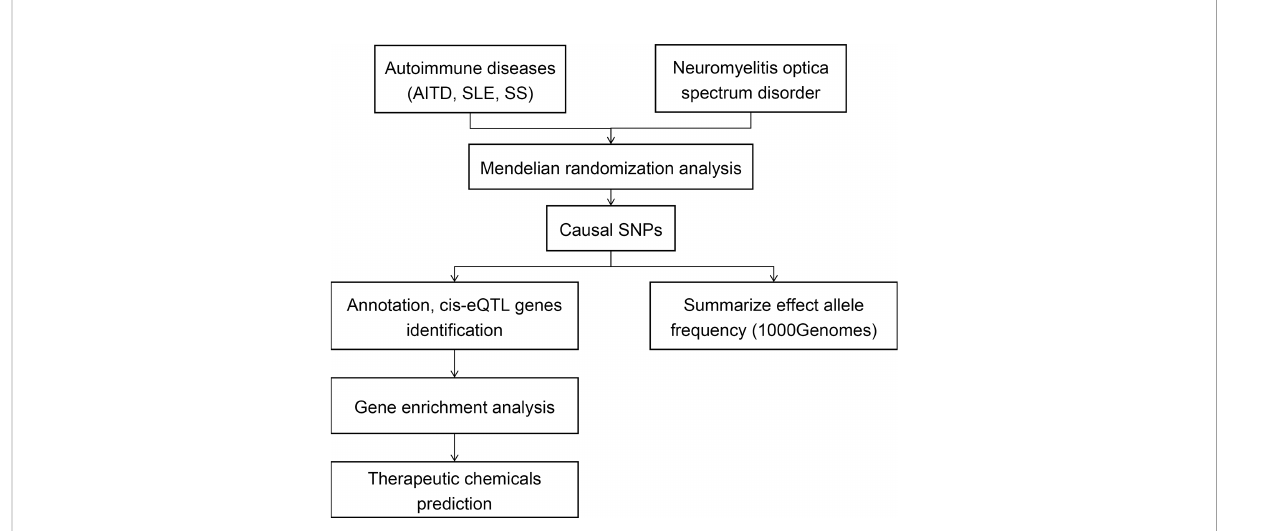
FIGURE 1 Flowchart of the study ’ s design. Summary data of GWAS traits were extracted, then MR analysis was performed to detect the causal relationships between NMOSD and other ADs (AITD, SLE, and SS). The frequencies of causal SNPs were searched in 1000 Genomes. The causal SNPs were annotated, and gene enrichment analysis was performed. Chemicals that may affect the enriched pathways were